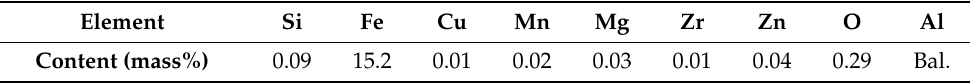
Figure 1. SEM image showing particle morphology of the studied Al–15% Fe alloy powder. Table 1. Composition of raw Al–15%Fe alloy powder.